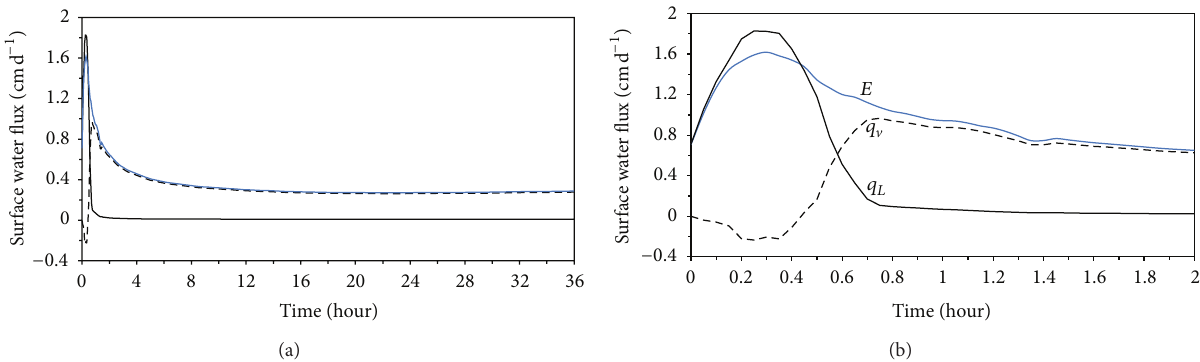
Figure 4: Calculated surface liquid-fluxes 𝑞 𝐿0 (solid line), vapor-fluxes 𝑞 V 0 , (dashed line), and surface evaporation rate 𝐸 (blue solid line) during whole simulation period (a). (b) is plotted during 2 hours for the emphasis of the early periods of soil drying.